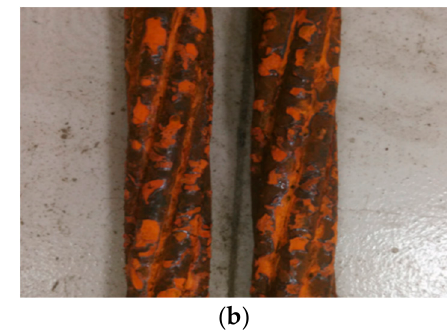
Figure 3. ( a,b ) Corrosion results of the steel strand.